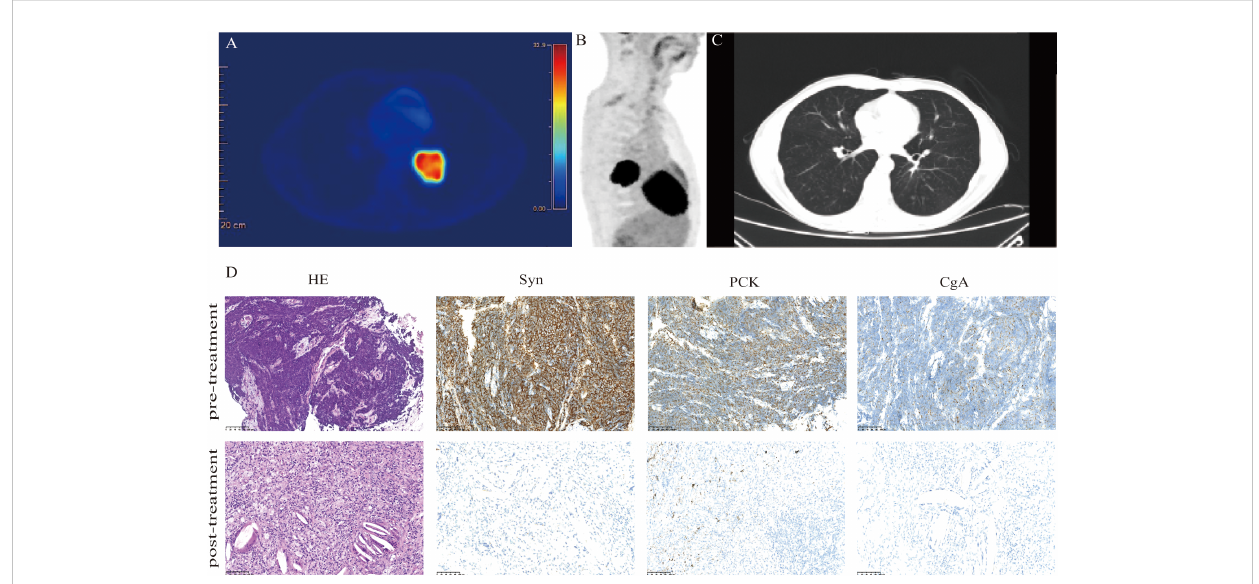
FIGURE 1 Clinical and pathological response. Images (A, B) show FDG uptake in the lung parenchyma. (C) CT images acquired after two circles of neoadjuvant tislelizumab plus chemotherapy display a decrease in the size of the tumor lesion. (D) Hematoxylin-eosin (HE) and immunohistochemistry staining in the tumor bed. The staining of the lung mass (lower panels) showed no viable tumor cells; negative for synaptophysin (Syn), pan-cytokeratin (PCK), and chromogranin A (CgA). Scale bars: D = 100